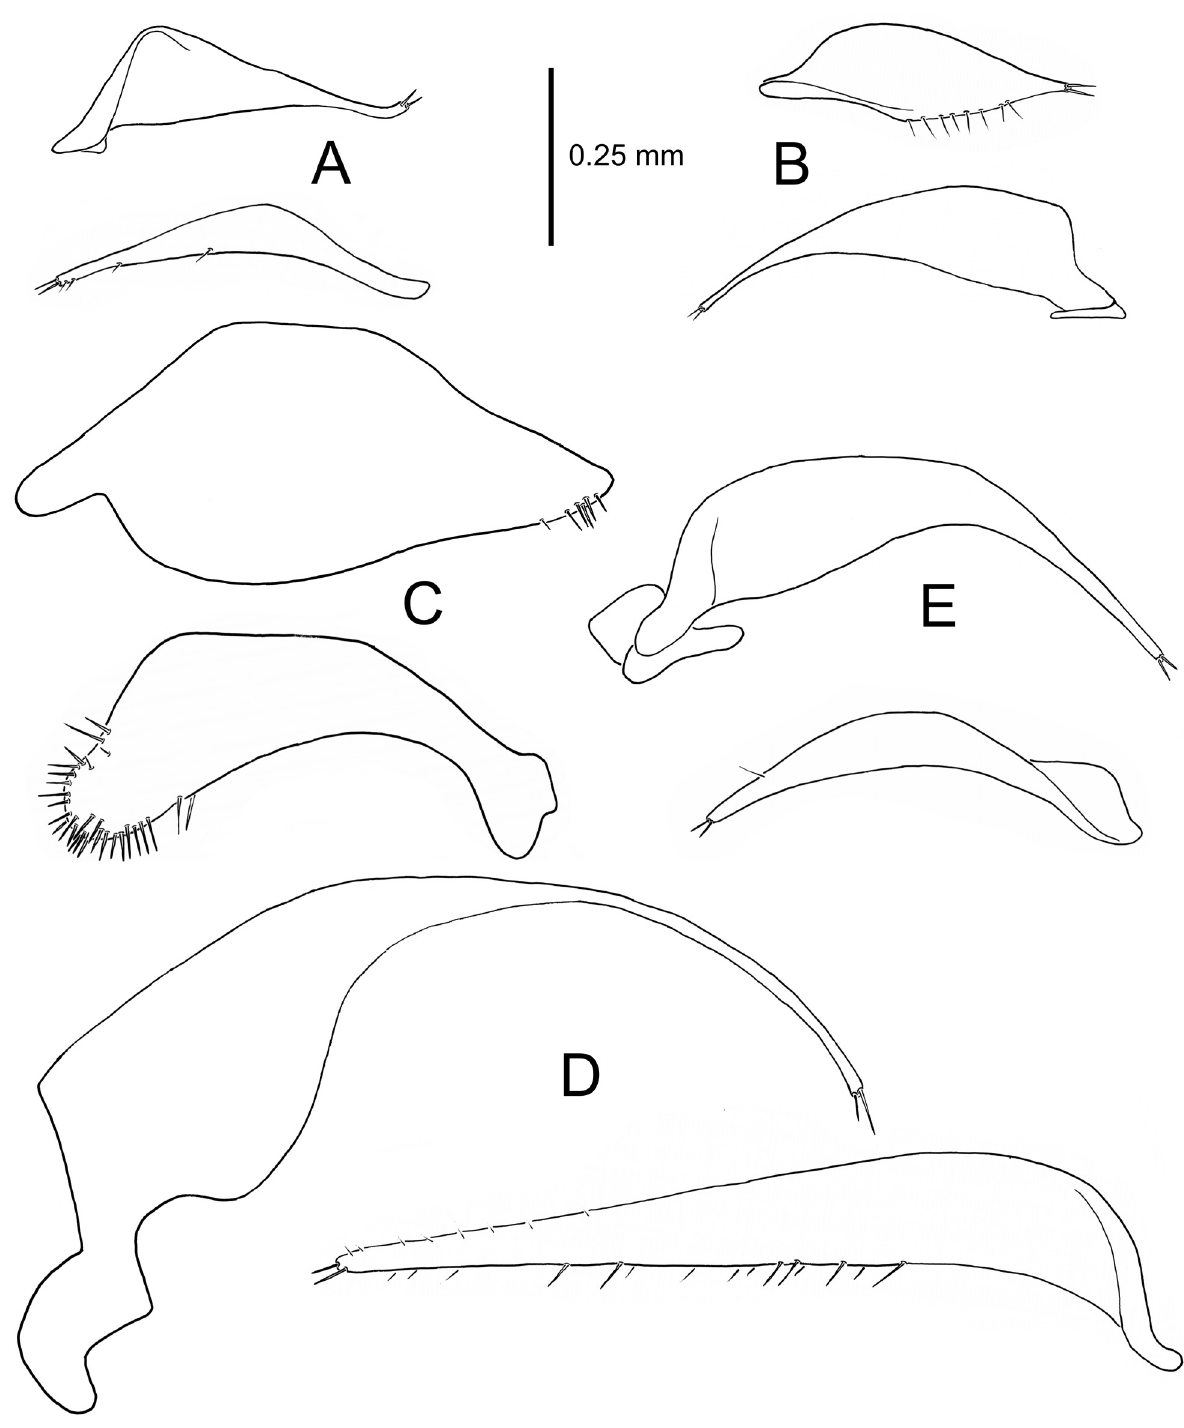
Figure 5. Paired left (above) and right (below) parameres of Mecyclothorax spp. (ectal view): A , M. blackburni ; B , M. storeyi ; C , M. amplipennis ; D , M. montivagus ; E , M. laterobustus. As the aedeagal assembly of M. storeyi males is inverted relative to other Me- cyclothorax species (Moore 1984), the configuration of the upper, or right paramere of M. storeyi should be compared to the ventral, or left parameres of the other species, and vice